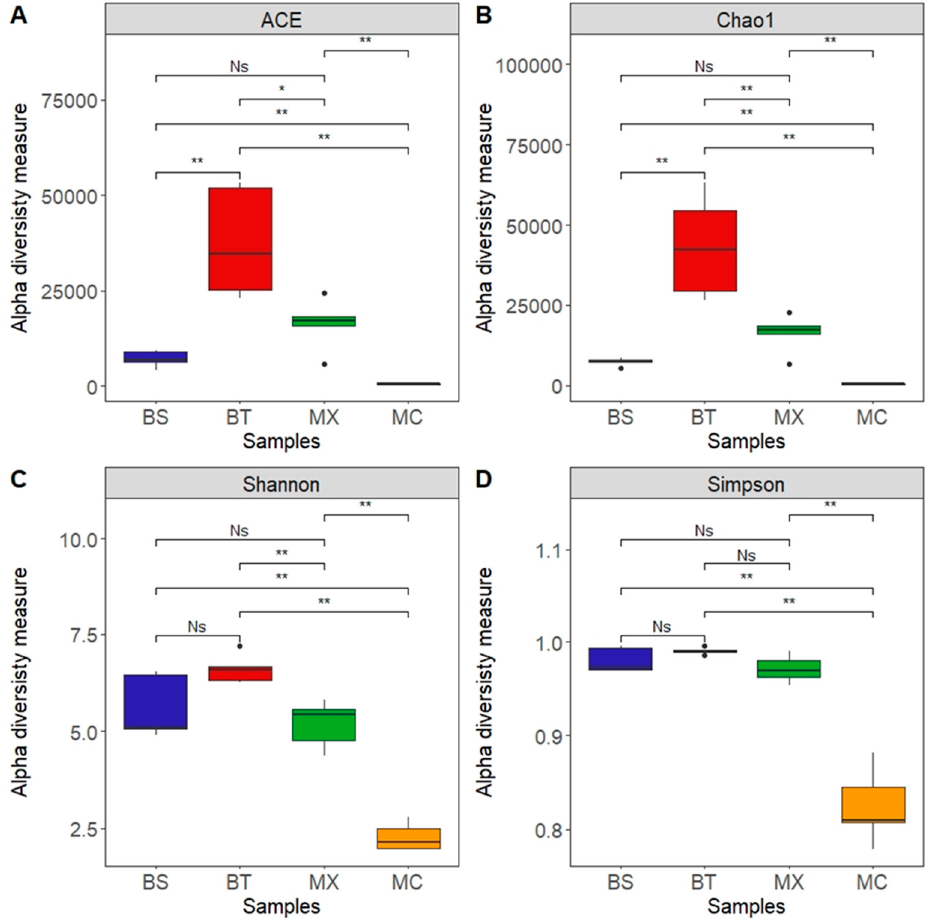
Figure 1. Alpha diversity was shown in each city. Blue: Busan, Red: Boston, Green: Mexico City, Orange: Moscow. Statistically significant differences between the two sample types were shown as follows. **: p < 0.01, *: p < 0.05, NS: Non-Significant.